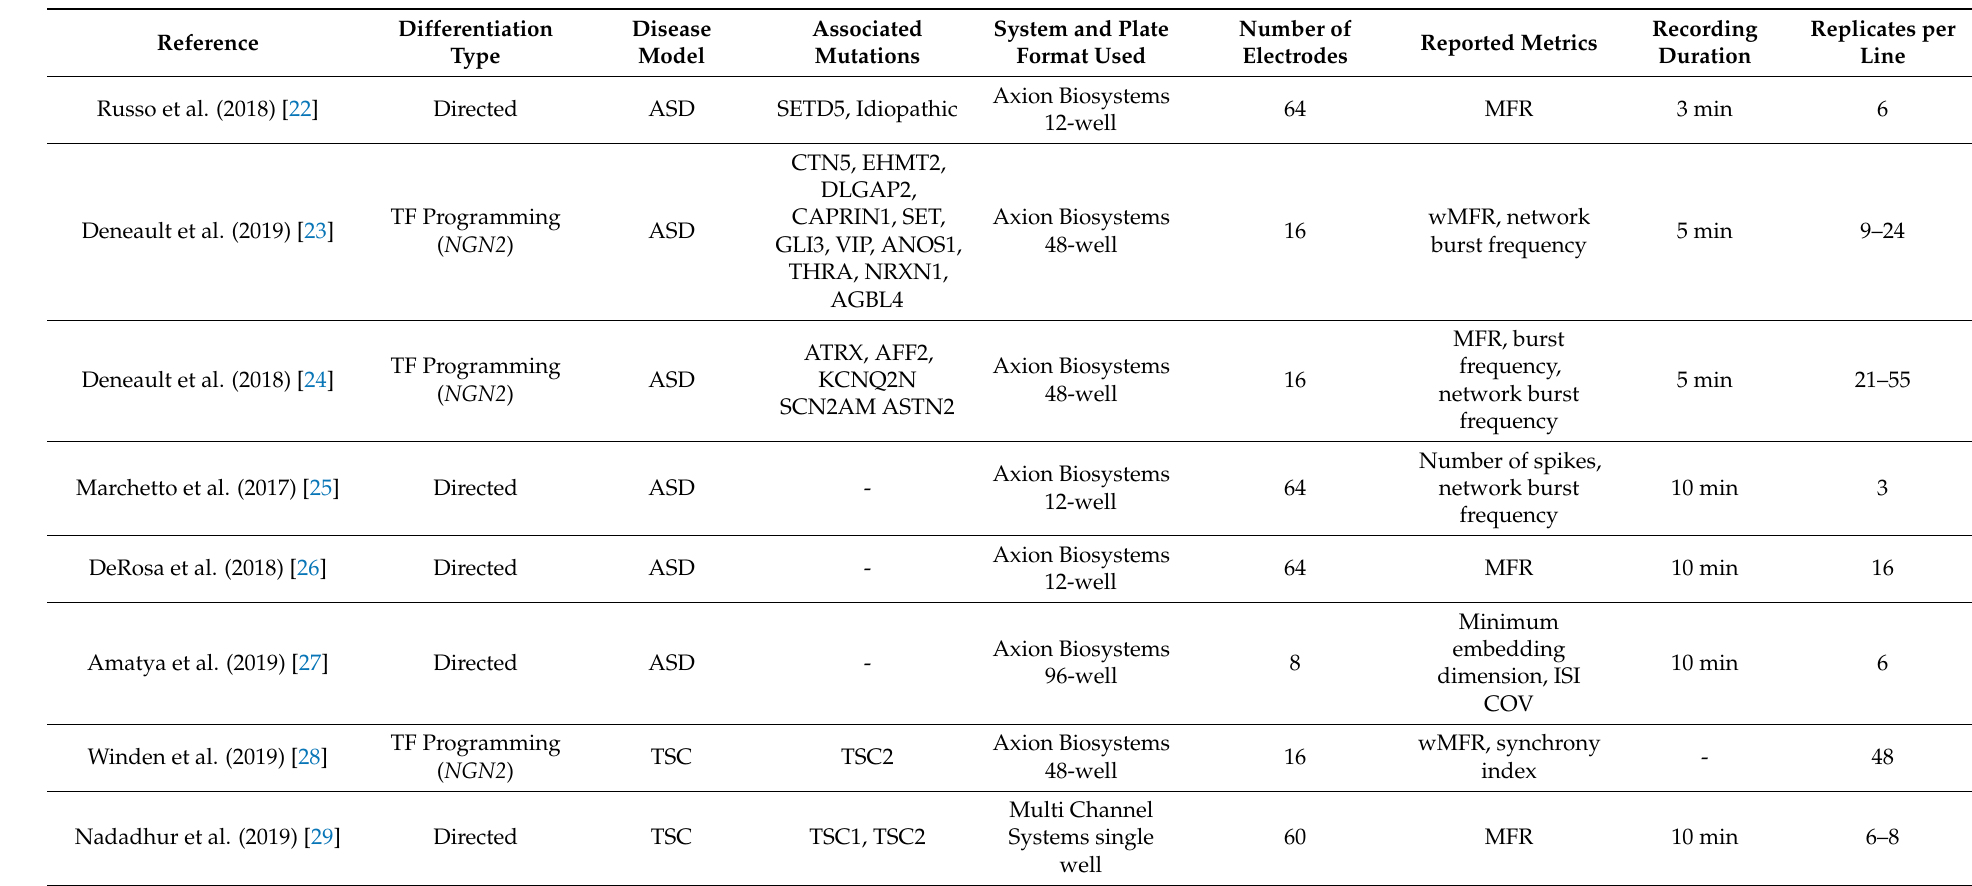
Table 1. Overview of MEA assays in recent iPSC disease modeling studies. ASD = autism spectrum disorder, TSC = tuberous sclerosis complex, FXS = fragile